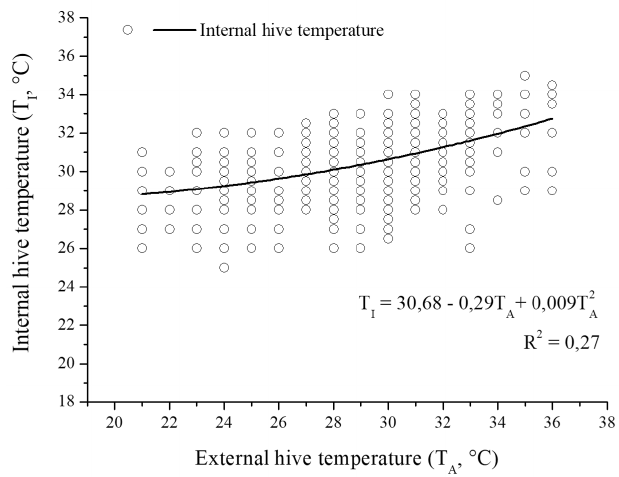
Fig 1 . Internal hive temperature (T function of the external hive temperature (T